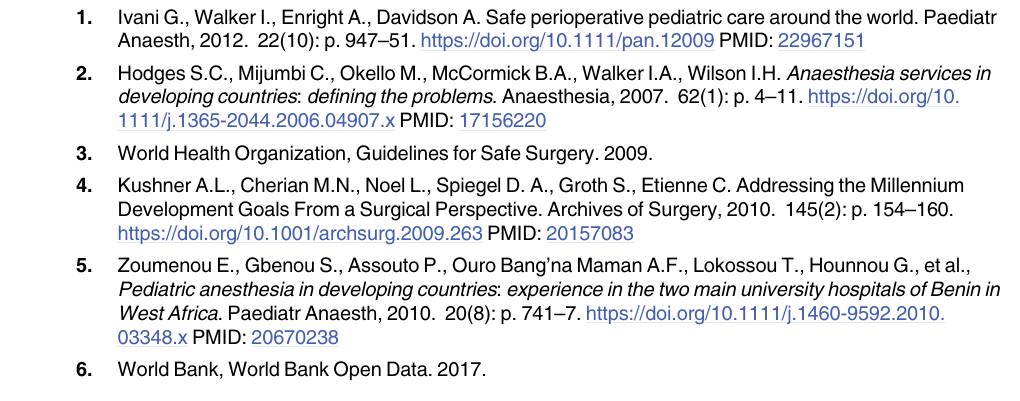
S2 Table. Adverse event definitions. S3 Table. General characteristics. S4 Table. Structure parameters. S5 Table. Process parameters.